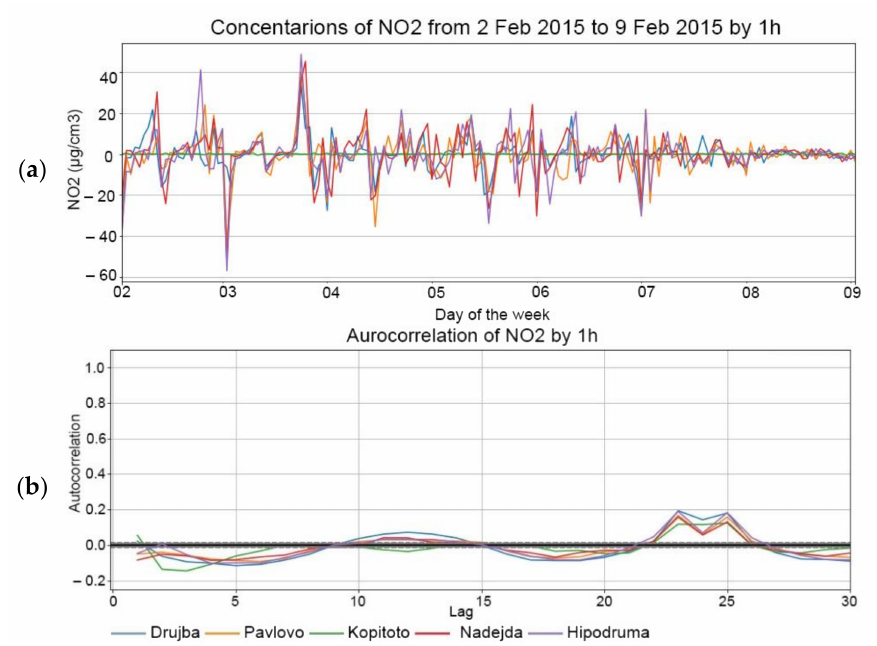
Figure 9. The signal for the different stations corresponding to NO 2 for granularity 1 h with lag difference 1 ( a ) and its autocorrelation ( b ).